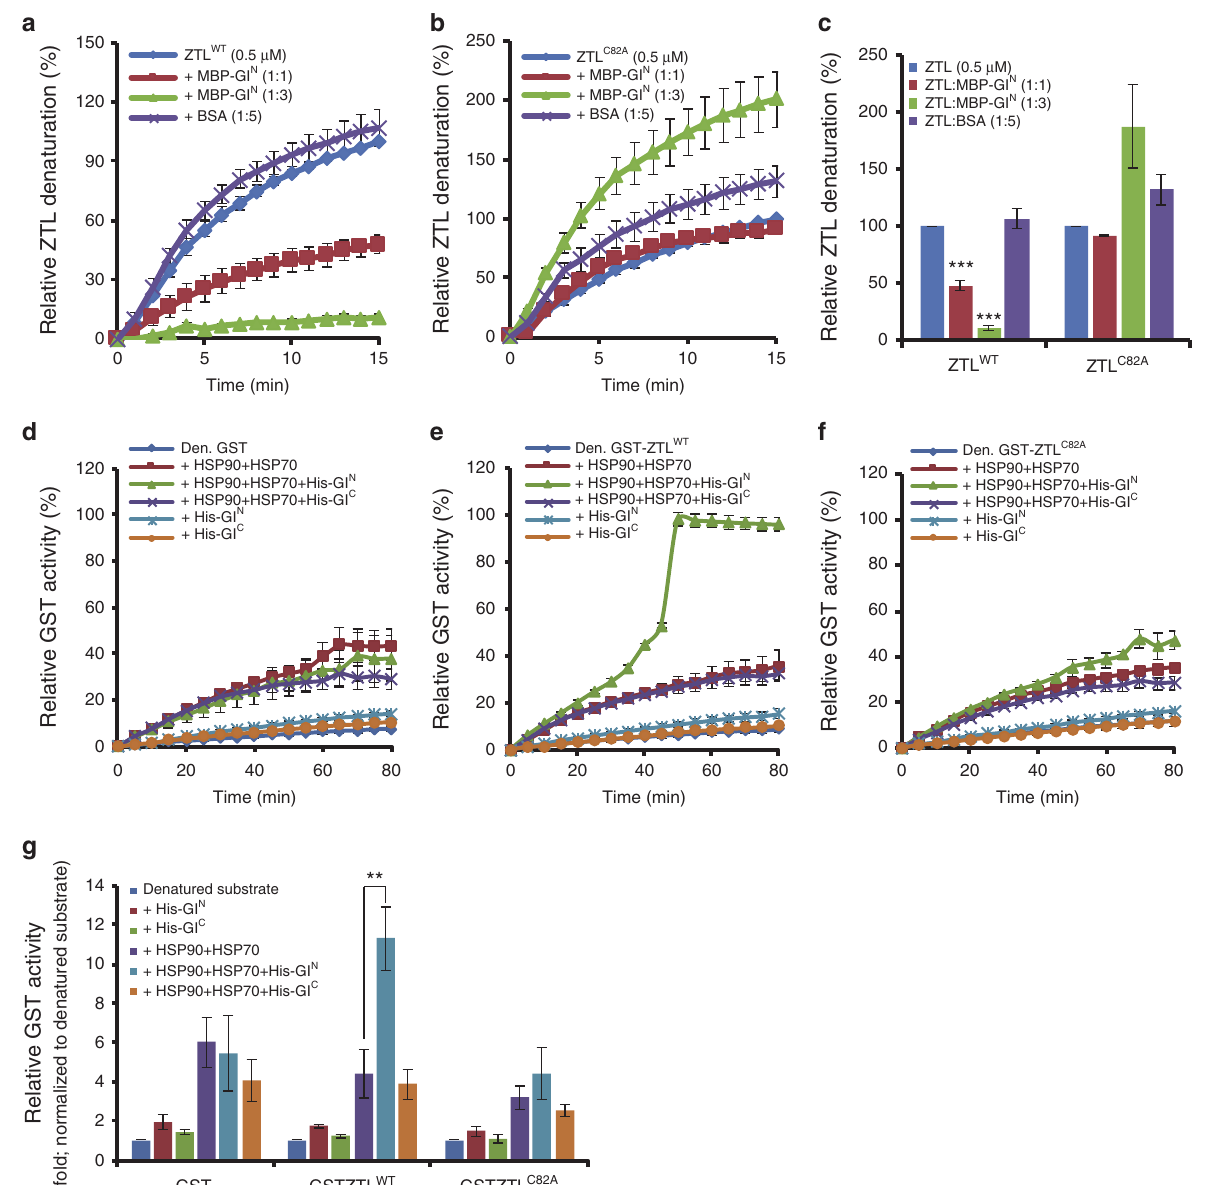
Fig. 2 ZTL is a speci fi c client of GI N chaperone activity in vitro. a MBP-GI N decreases heat-mediated ZTL WT aggregation with increasing levels of MBP-GI N . b MBP-GI N has no effect or increases heat-mediated aggregation of the ZTL C82A allele. c The mean denaturation state at the treatment endpoint of a and b relative to thermal-denaturation of ZTL WT or ZTL C82A alone. BSA used as a non-speci fi c protein control. Holdase activity of MBP-GI N was measured as the change in turbidity at 340 nm (aggregation of ZTL WT or ZTL C82A (0.5 μ M)) under thermal denaturing conditions (45 °C) for 15 min. The value of ZTL WT or ZTL C82A alone at 15 min was set to 100%, and turbidity at 340 nm from each treatment expressed relative to it. BSA used as a non- speci fi c protein control. d – f GI acts synergistically with HSP90 and HSP70 to reactivate denatured GST-ZTL. d GST, e GST-ZTL WT , and f GST-ZTL C82A were heat-denatured at 45 °C and immediately mixed with His-GI N (0.05 μ M) or His-GI C (0.05 μ M) in the absence or presence of HSP90 (0.1 μ M) and HSP70 (0.5 μ M). Enzyme activity of undenatured GST, GST-ZTL WT , and GST-ZTL C82A was set to 100% for d , e and f , respectively. g Mean GST activity at the treatment endpoint of d – f was normalized to the spontaneously refolding value of denatured GST or GST-fusions set to 1. The foldase assay determined GST activity by measuring the formation of a GS-DNB conjugate (GST reaction product) as determined by absorbance at 340 nm (Abs 340 ). ** P <